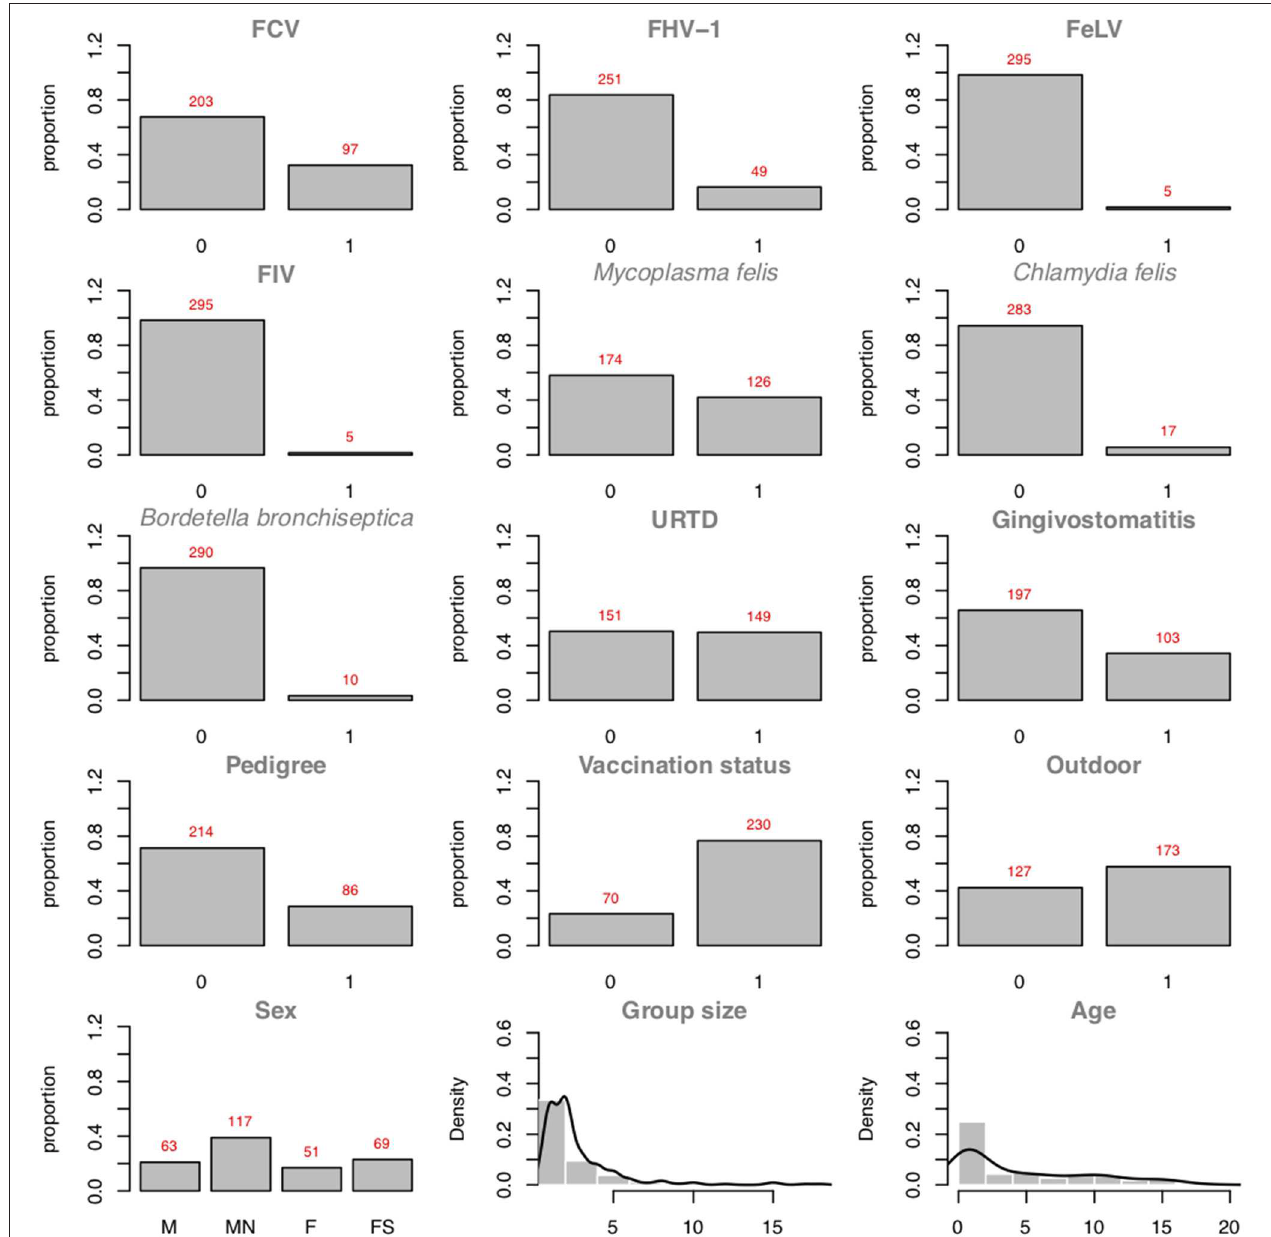
FIGURE 5 | Plots of the variable distributions in the FCV dataset. Discrete data are represented using their proportions. Continuous data are represented using histograms and their densities ( Group Size and Age ).